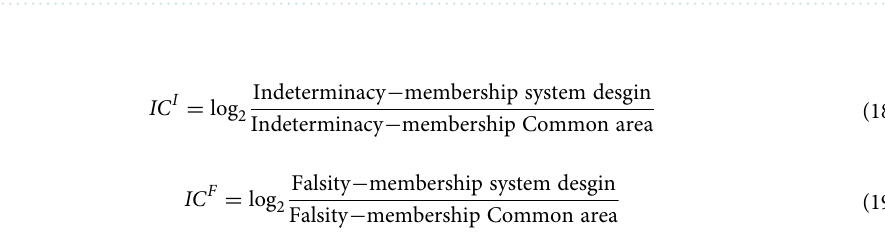
Table 1. Linguistic variables of criteria and alternatives in the form of